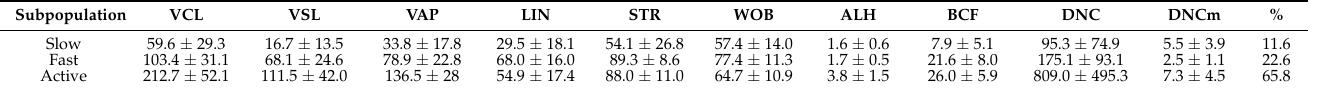
Figure 5. Effects on bull sperm motility of melatonin receptors agonists (PHE: Phenylmelatonin; 8MPDOT: 8-Methoxy-2-propionamidotetralin) or antagonists with 10 nM melatonin (LUZ: Luzindole; 4PPDOT: cis-4-Phenyl-2-propionamidotetralin); CTL: Control; CTLm: Control with 10 nM melatonin. Plots show mean ± SEM for each treatment of seven males. ( a ) Percentage of motile spermatozoa; ( b ) Percentage of progressive spermatozoa; ( c ) “Slow” spermatozoa, low velocity and linearity; ( d ) “Fast” spermatozoa, high velocity and linearity; ( e ) “Active” spermatozoa, highest velocity and high lateral movement. Treatments not sharing the same letters differ significantly ( p < 0.05). Table 1. Descriptive statistics of the bull sperm subpopulations yielded by the clustering of observa- tions from CASA data. Parameters for each subpopulation are summarized by the median ± SD of each CASA variable. The last column is the overall proportion of each